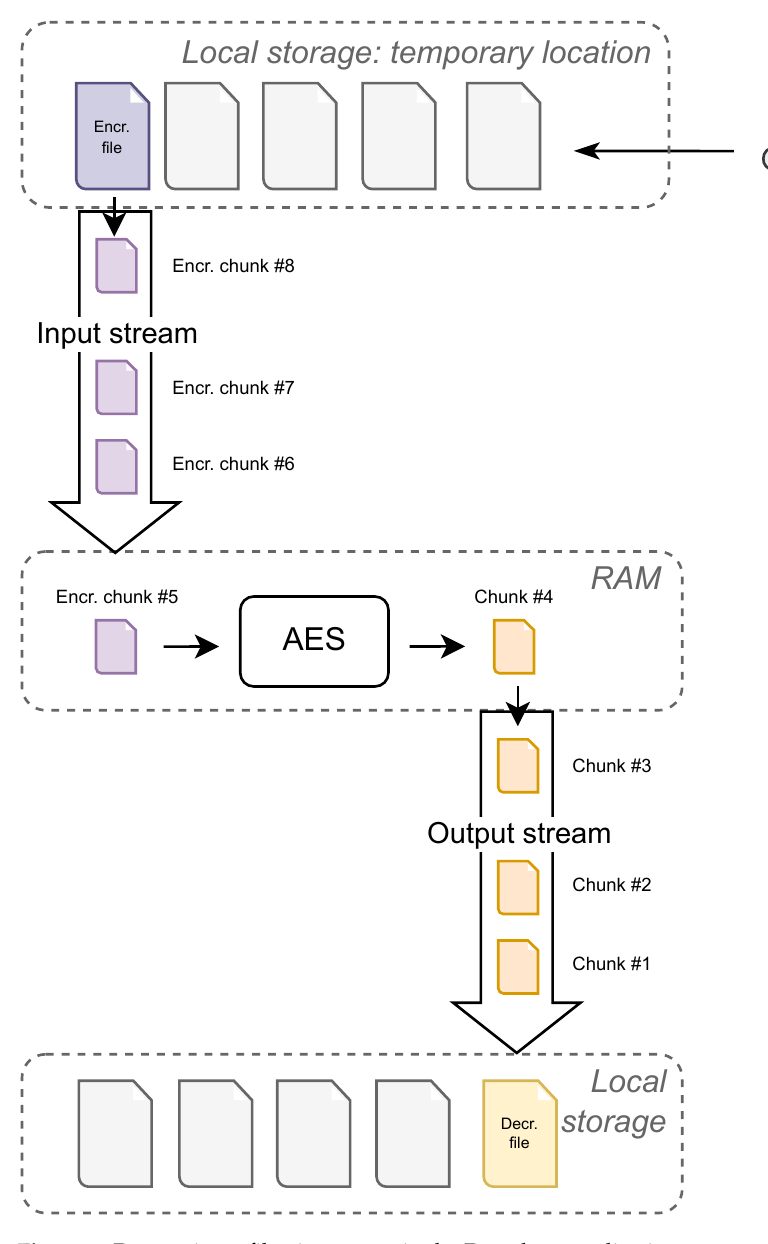
Figure 4. Decrypting a file via streams in the Datachest